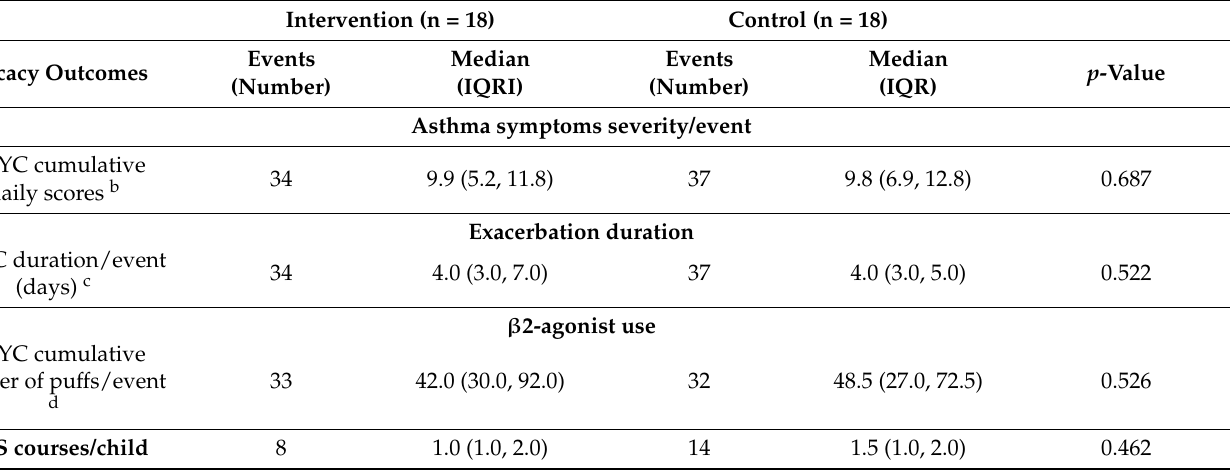
Table 4. Severity and duration of Asthma exacerbation (with and without upper respiratory tract infections) reported by parent during the 6-month intervention using the Asthma flare-up diary for young children (ADYC) a .